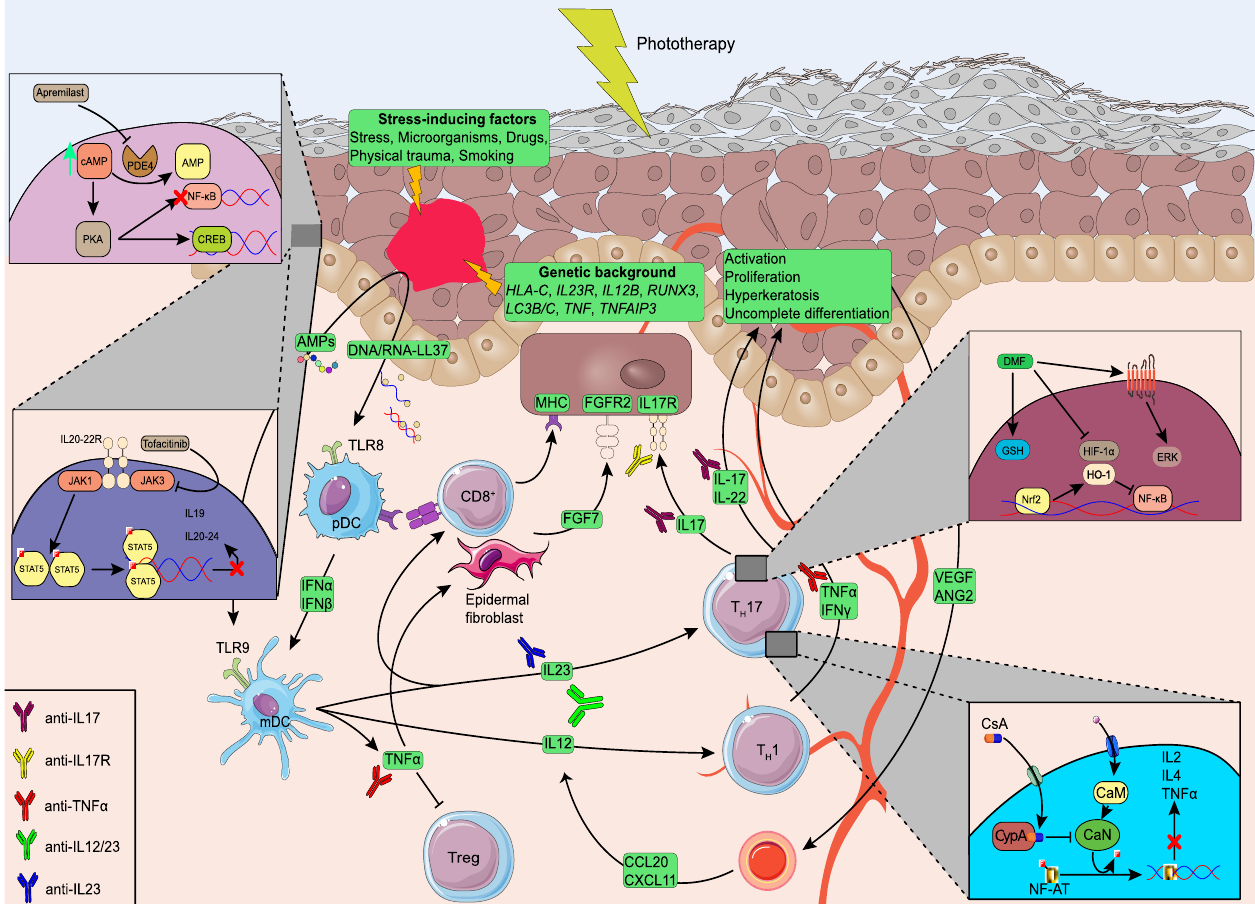
Figure 1. Pathophysiology of psoriasis and major therapeutic approaches.